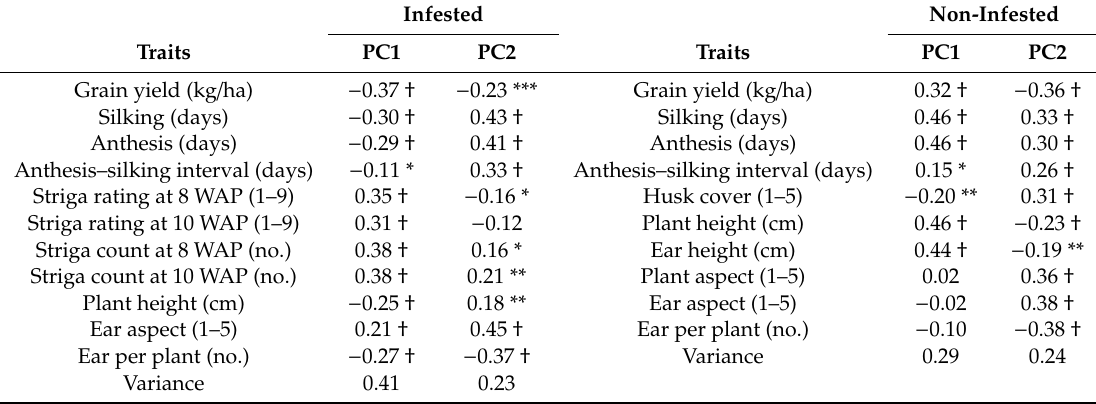
Table 8. Eigenvectors of the first two principal component axes (PC1 and PC2) for yellow maize testcrosses involving the testers evaluated under Striga -infested and non-infested